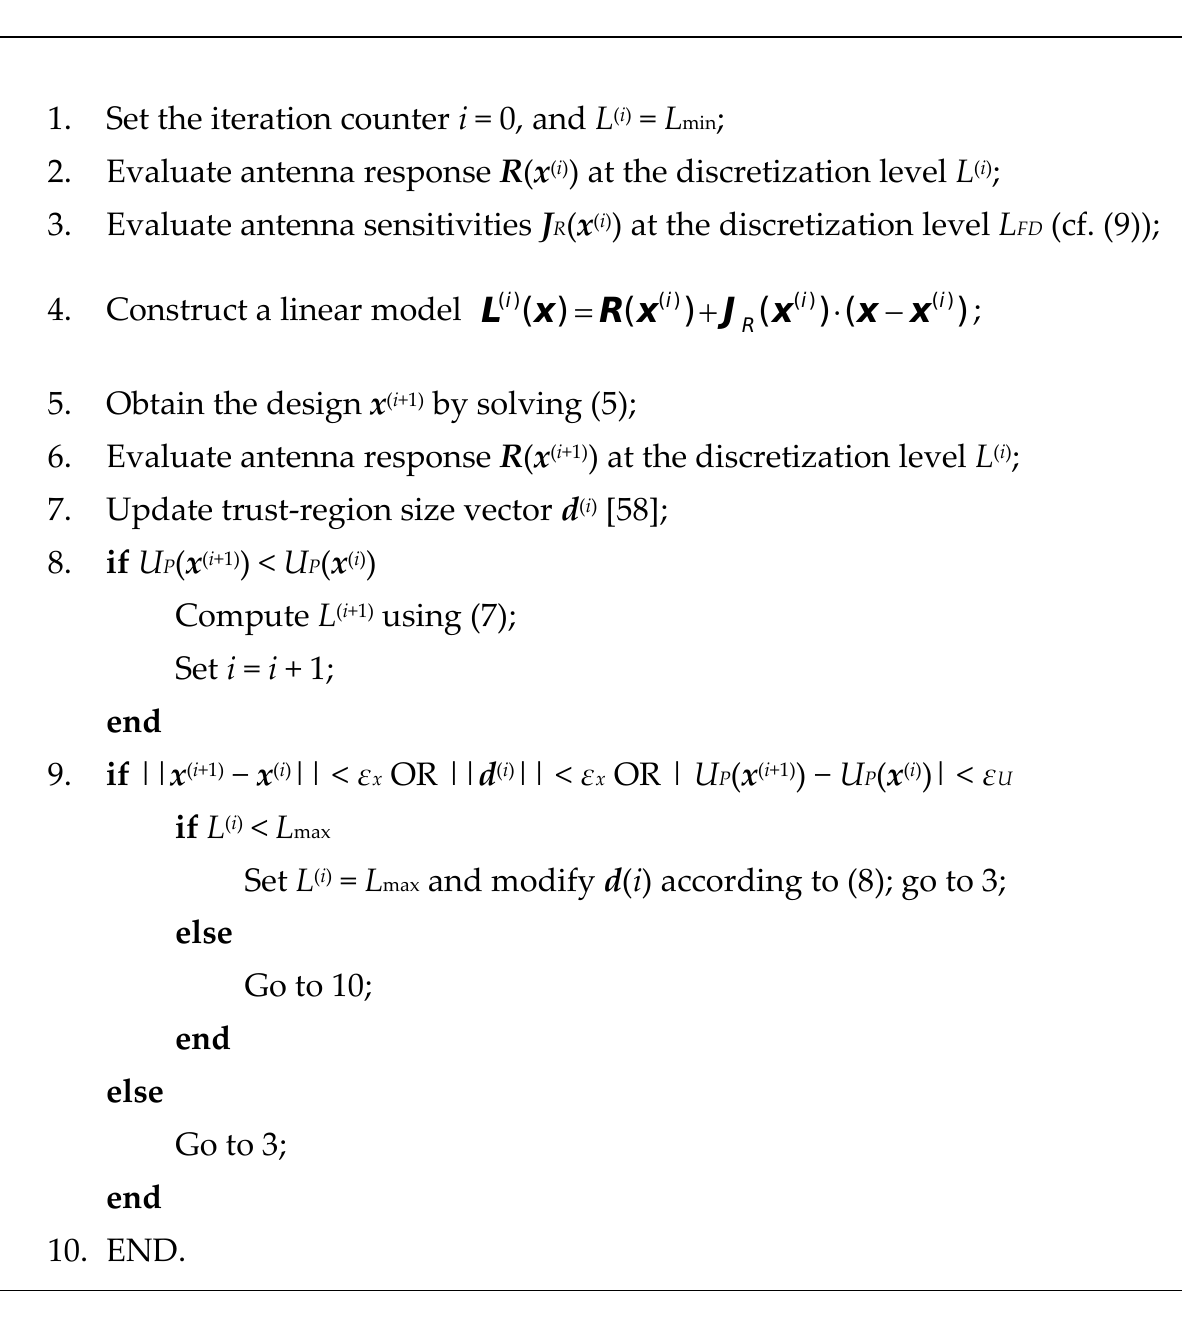
Figure 3. EM-driven size reduction using multi-fidelity simulations: operational flow. In the presented pseudocode, the relevant antenna responses (EM-simulated at the design x ) are denoted as R ( x ); J R ( x ) stand for the sensitivity matrix, also at the design x .